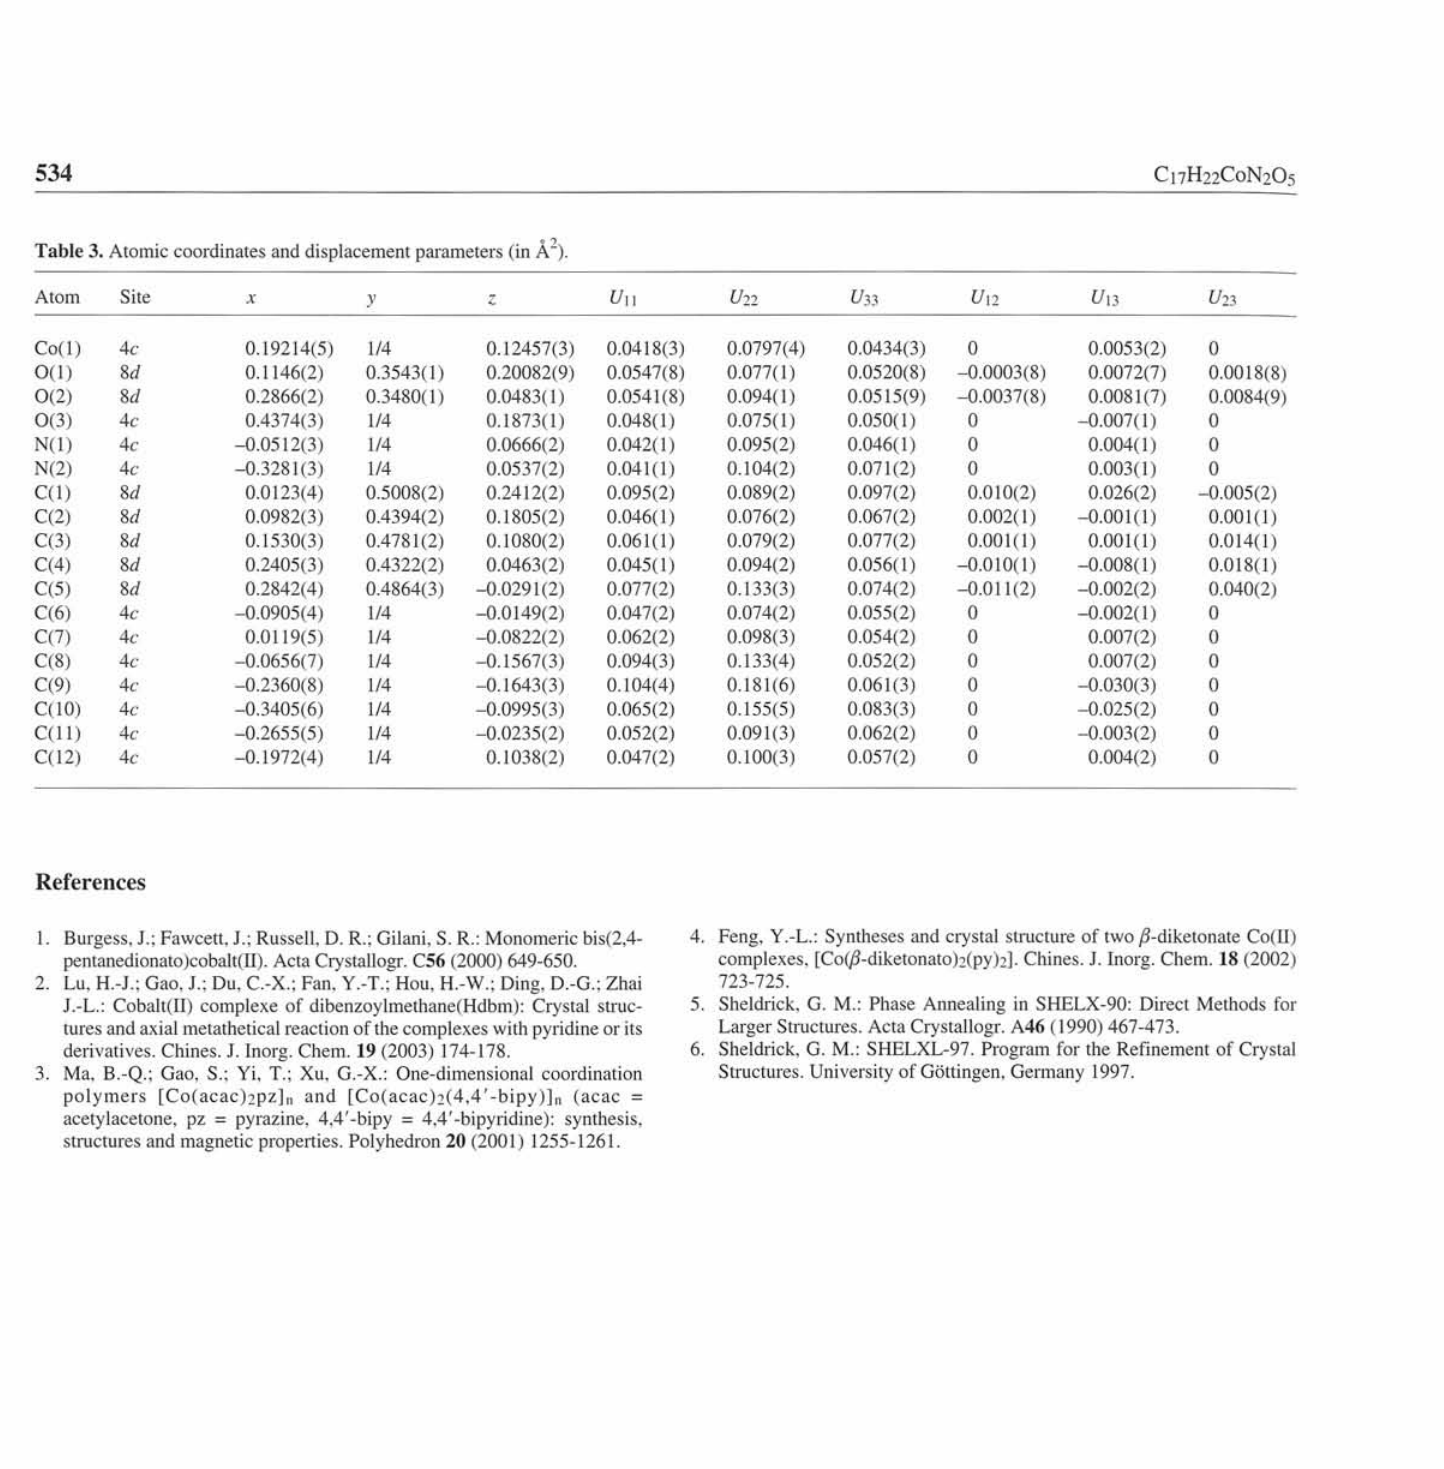
Table 3. Atomic coordinates and displacement parameters (in Â